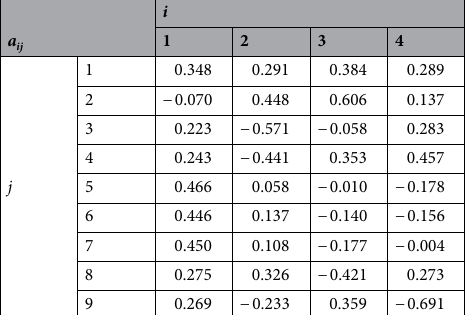
Table 1. Principal component load matrix of the proximal